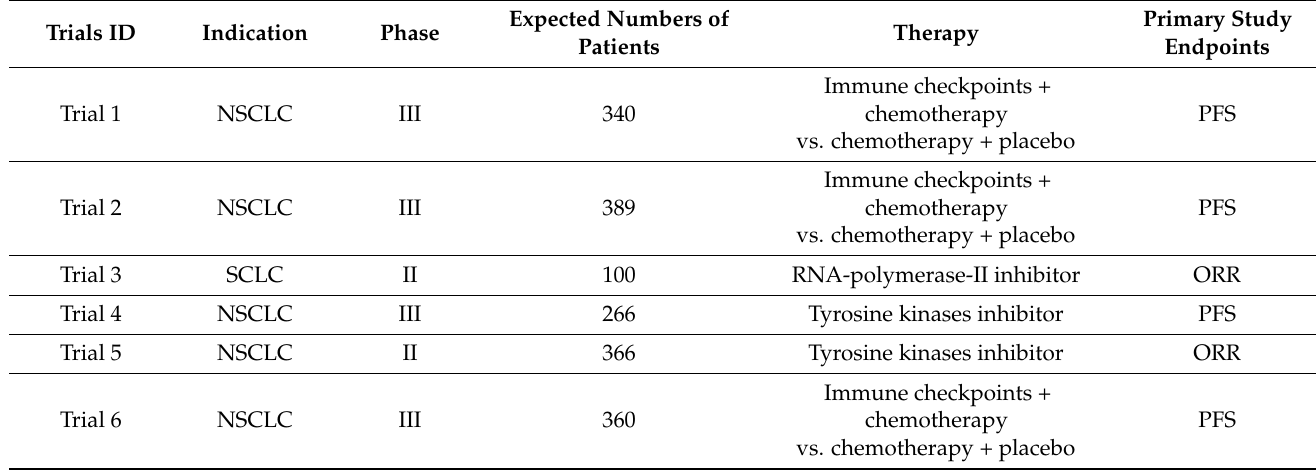
Table 1. Description of included trials. Primary study endpoints were: progression-free survival (PFS) and overall response rate (ORR). Most patients were treated for non-small cell lung cancer (NSCLC).